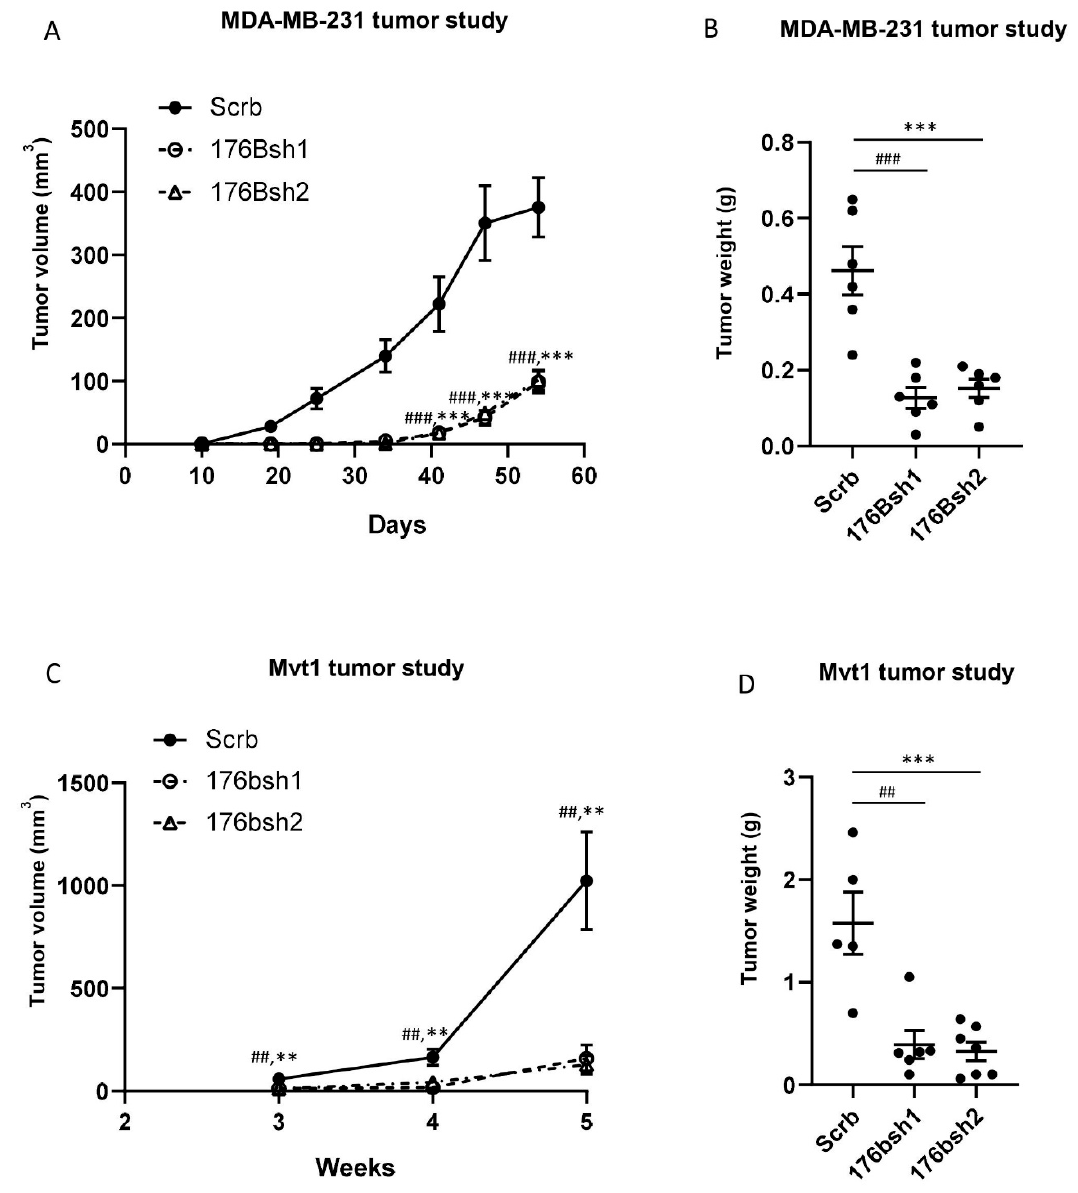
Figure 2. TMEM176B knockdown suppressed MDA-MB-231 and Mvt1 tumor growth in vivo. ( A ) Growth charts of MDA-MB-231 control (Scrb), and TMEM176B-silenced (176Bsh1 and 176Bsh2) tumor xenografts in the Rag1 − / − female mice (n = 6 mice per group). ( B ) Tumor weight at the end of the study. ( C ) Growth charts of Mvt1 control (Scrb), and Tmem176B-silenced (176bsh1 and 176bsh2) syngeneic tumors in the FVB/n female mice (n = 5–7 mice per group). ( D )